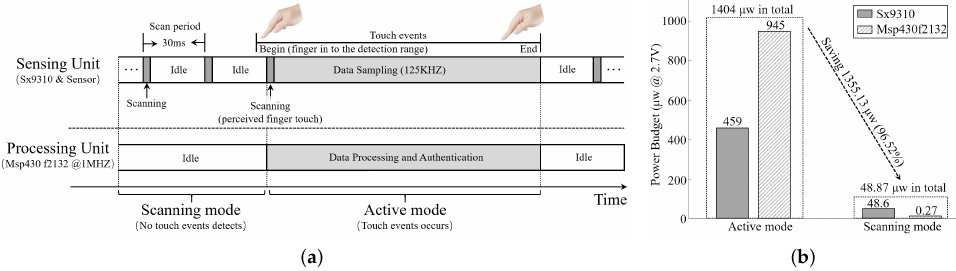
Figure 15. When the user’s finger enters the sensing range (2.5 cm in the test), BioTouch samples the sensed bio-capacitance and processes the data to authenticate the user. If the finger is out of range, BioTouch shuts down the processing unit and only scans the sensor periodically to further reduce power consumption. ( a ) System operating mode. ( b ) System power